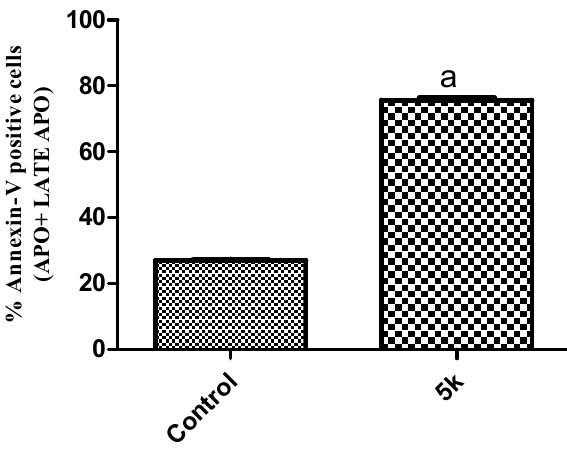
Figure 7. Effect of compound 5k on the percentage of annexin V–FITC-positive staining in MDA-MB-468 cells. Data are presented as means ± S.D. a Indicates statistical difference from control at p < 0.0001.